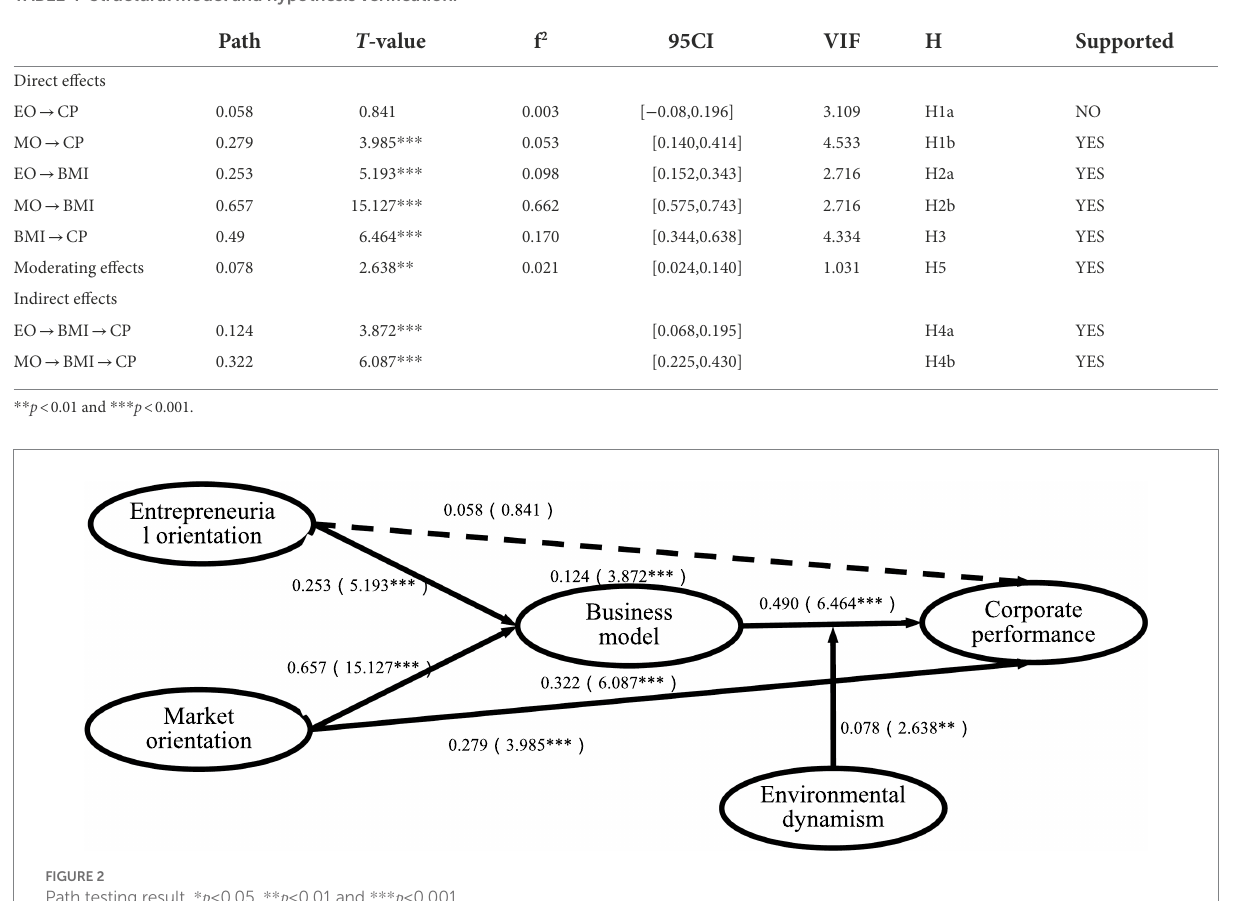
TABLE 4 Structural model and hypothesis verification.